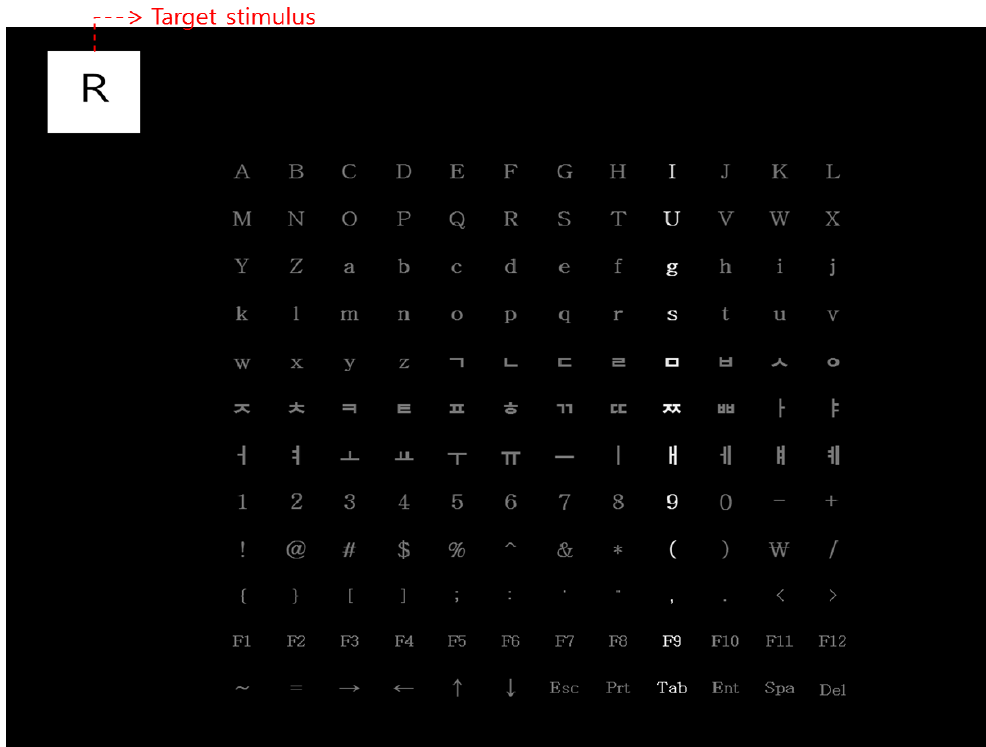
Figure 4. Proposed speller UI system of 12 × 12